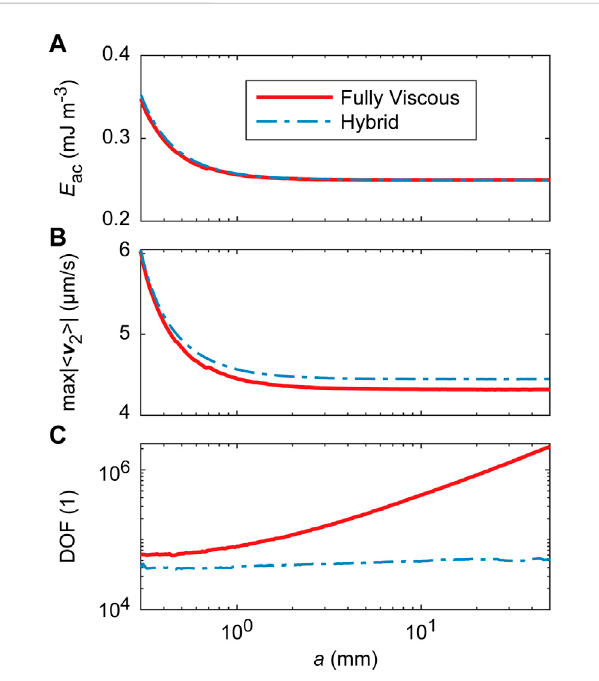
FIGURE 7 In fl uence of the channel width a on the performance of the Fully Viscous model and the Hybrid model for a resonant system with a sharp edge. Channel width is varied in the range of 0.3 mm ≤ a ≤ 3.5 mm at a fi xed frequency of f = 720 kHz to induce channel resonances. The channel contains a single sharp edge, as indicated in Figure 2, with h = 100 μ m, b = 150 μ m, α = 10 ° , and the sharp-edge rounding radius of δ /2. (A) Average acoustic energy density E ac , (B) maximal Eulerian streaming velocity magnitude | 〈 v 2 〉 |, and (C) scaling of the DOF with the channel width. The excitation is imposed in the same direction (in phase) at x =± a /2, with a fi xed amplitude v a = 1 mm s − 1 . The imposed excitation supports the odd resonances (modes 1, 3, ... ) that have a symmetric acoustic velocity fi eld about the plane of the symmetry x =0 at the sharp